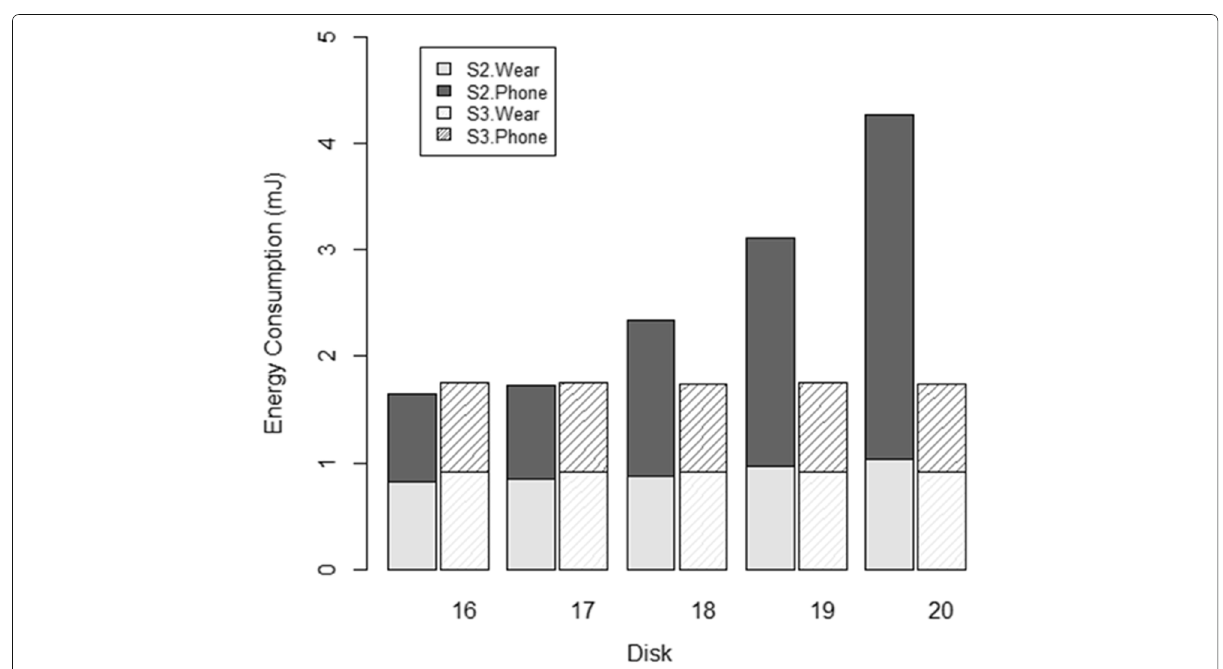
Fig. 11 Total energy consumption of smart devices